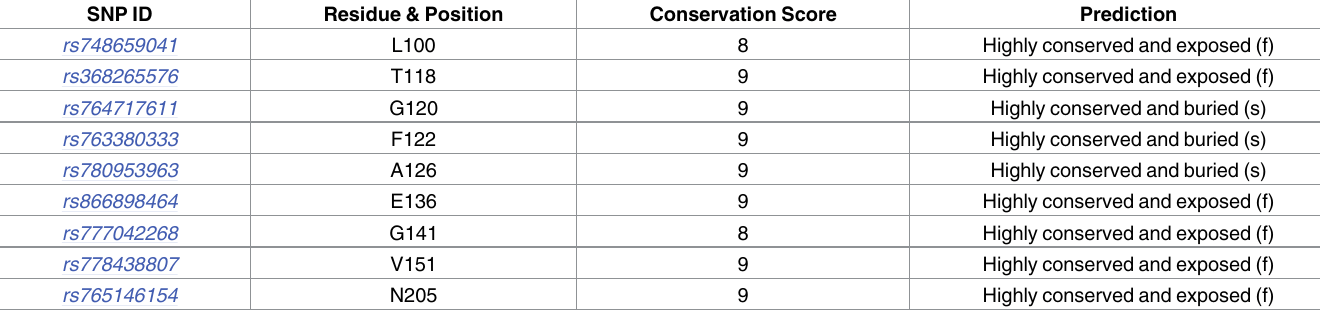
Table 4. ConSurf predictions showing conservation profile of amino acids in TAGAP . SNP ID Residue & Position Conservation Score